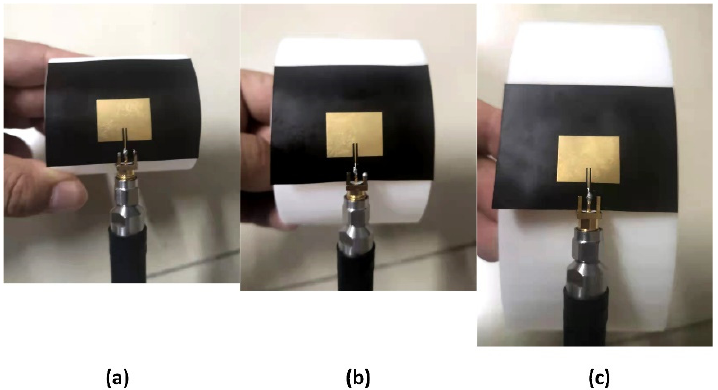
Figure 9. ( a ) Experimental sample of PI substrate antenna. ( b ) The cylindrical surface of the resin material manufactured based on 3D printing technology.